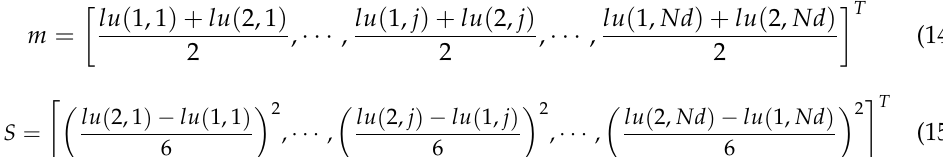
Algorithm 1 . The general pseudo-code of the IHKA.